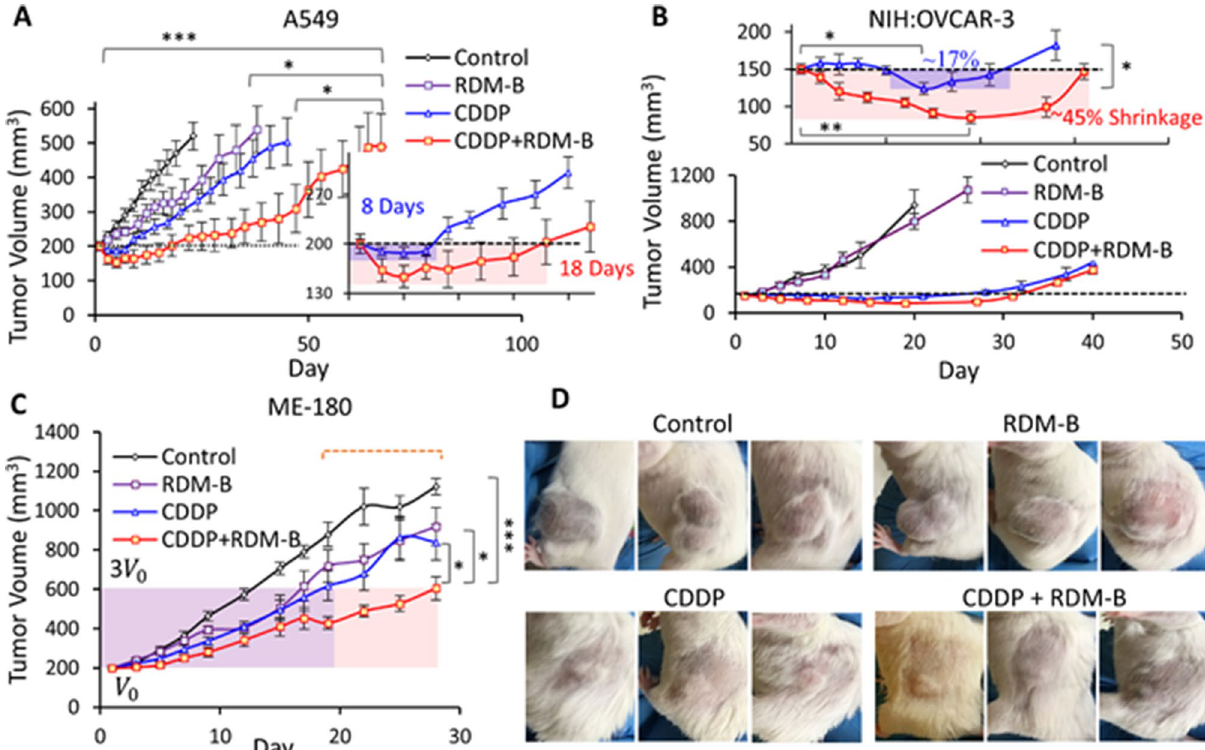
Figure 5. Mouse xenograft models of human lung (A549) cancer, human cervical (ME-180) cancer, and human ovarian (NIH:OVCAR-3) cancer treated by CDDP or RDM-B (BV10) alone and their combination. ( A – C ) Tumor growth curves for the A549, NIH:OVCAR-3, and ME-180 models, respectively, where error bars represent the standard error of the mean (s.e.m.). ( D ) Representative pictures of mice bearing ovarian tumors.